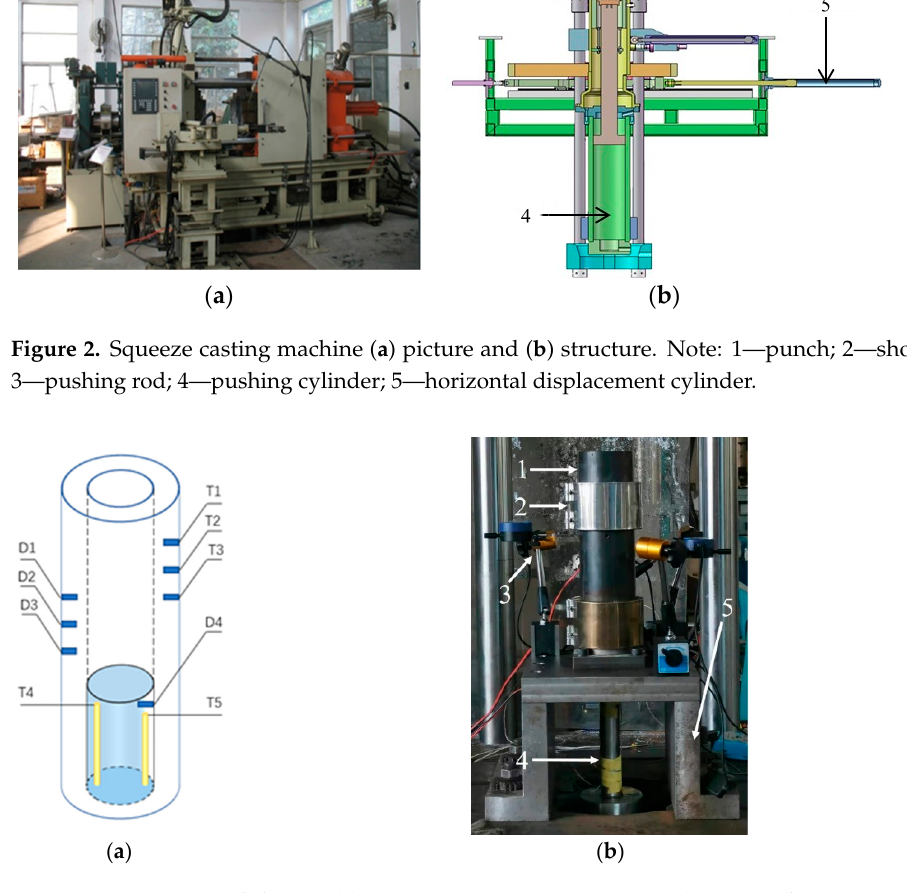
Table 1. Material parameters of the parts in the FE (finite element)